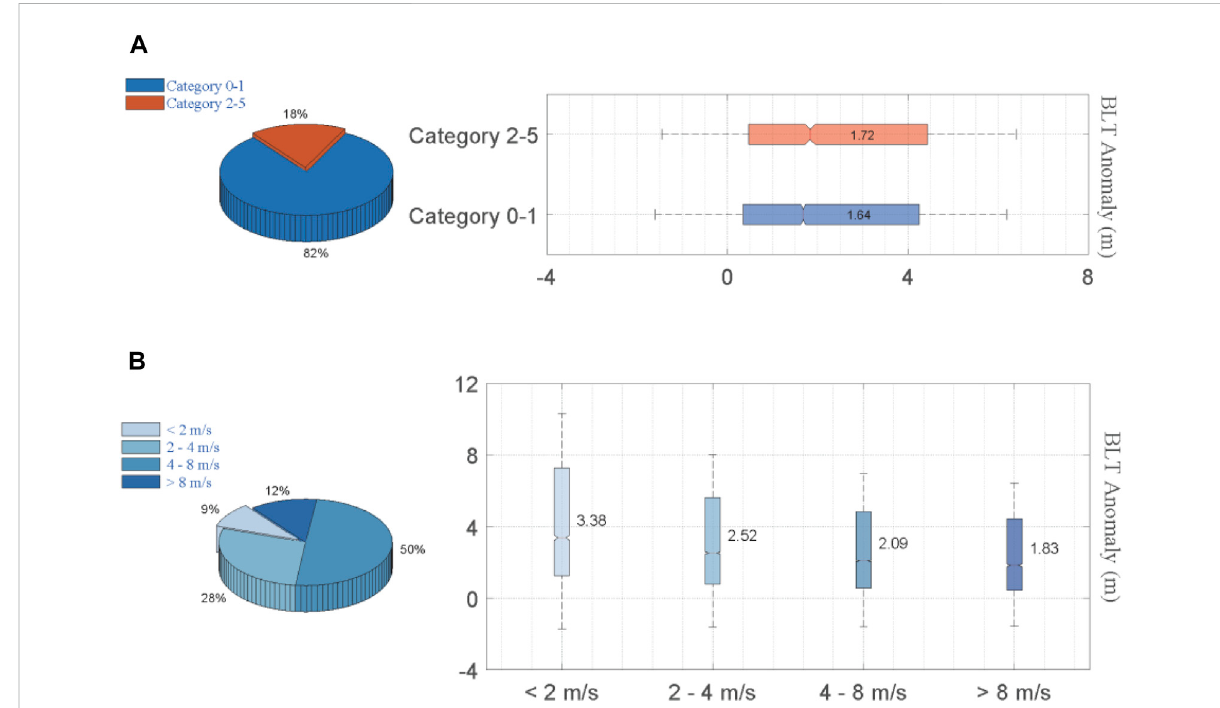
Thepiecharts(left)in (A) and (B) showthepercentage ofsamplesizeunderdifferentTCcharacteristics(totalsamplesize:50339). Theboxplots (right)in (A) and (B) representtherelationshipbetweentheBLTanomalyandTCintensityaswellasitstranslationspeed,respectively.Thenumbersin the fi gure represent the size of the 50th percentile. The difference between the two adjacent groups is statistically signi fi cant above the 99% con fi dence level based on the Student ’ s t -test.